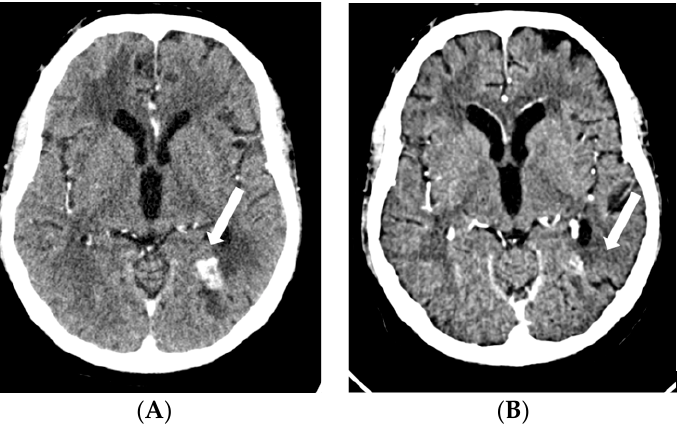
Figure 6. CT scan showing left parieto-occipital metastases before (( A ), 17 mm) and after 3 cycles of EV (( B ), 9 mm). Abbreviations: CT, computed tomography; EV, enfortumab vedotin.